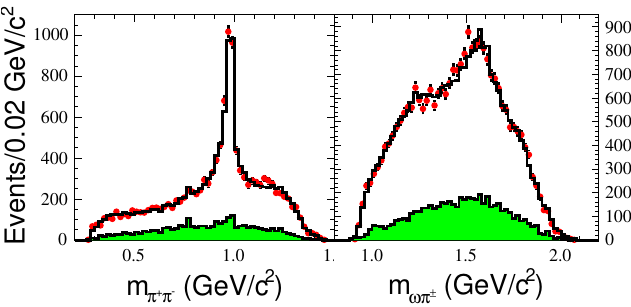
and m for group A data sets. π + π − ωπ ±